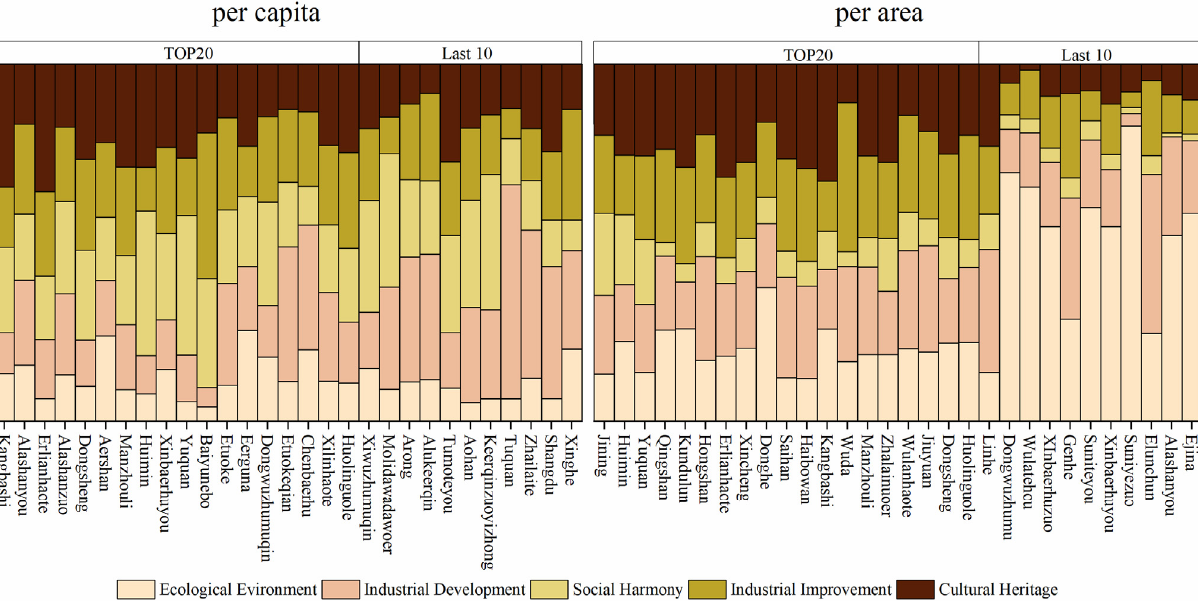
Figure 8. Beautiful Inner Mongolia construction evaluation based on POI quantity per capita and per area, visualized as percentage stacked histograms (TOP20: The top 20 regions in terms of comprehensive index values; Last 10: The last 10 regions in terms of comprehensive index values).